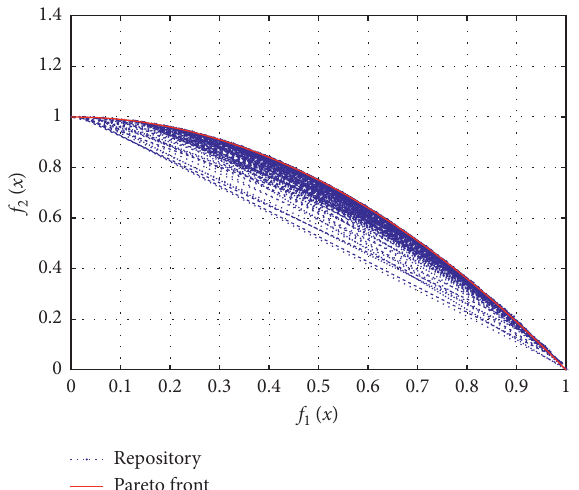
Figure 6: Pareto front produced by MOLFA for the ZDT4 test